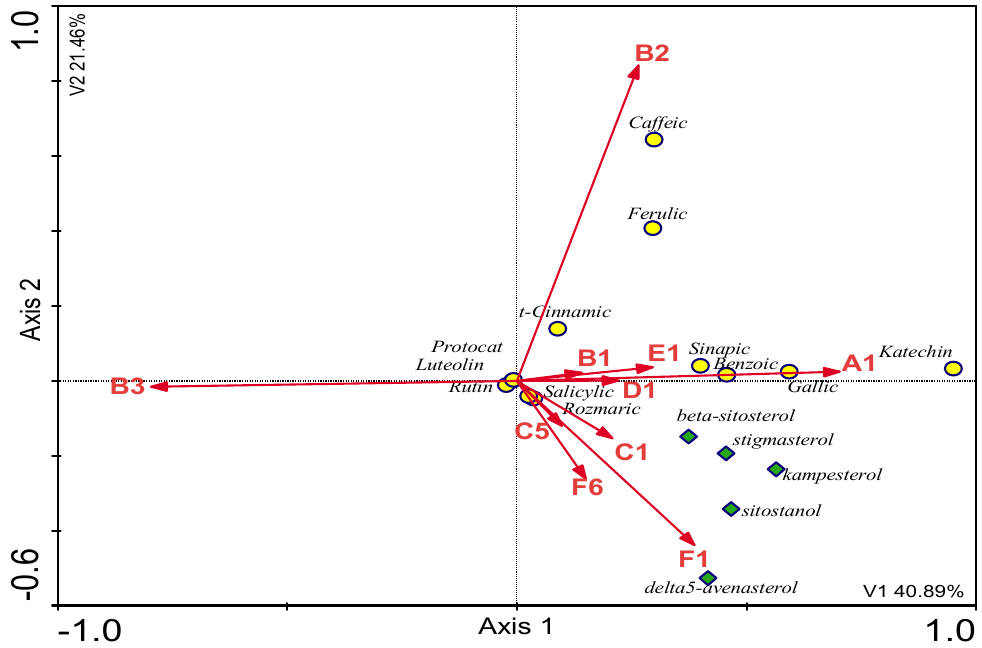
Figure 7. The CCA model. The tested compounds (polyphenols and sterols) distribution in plant material of the studied species. In terms of general indicators of TFC, TPC, and ABTS + , the highest concentrations were recorded in fruits and seeds of beach rose and elderberry flowers. In addition, higher concentrations of organic acids were found in the rowan, guelder rose, and sea buckthorn fruits. In contrast, the highest content of lycopene and lutein was recorded for the bitter melon and elderberry fruits (Figure 8).